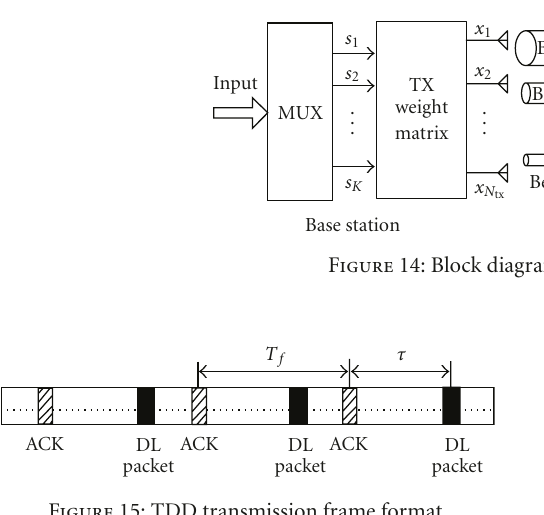
Figure 15: TDD transmission frame format.